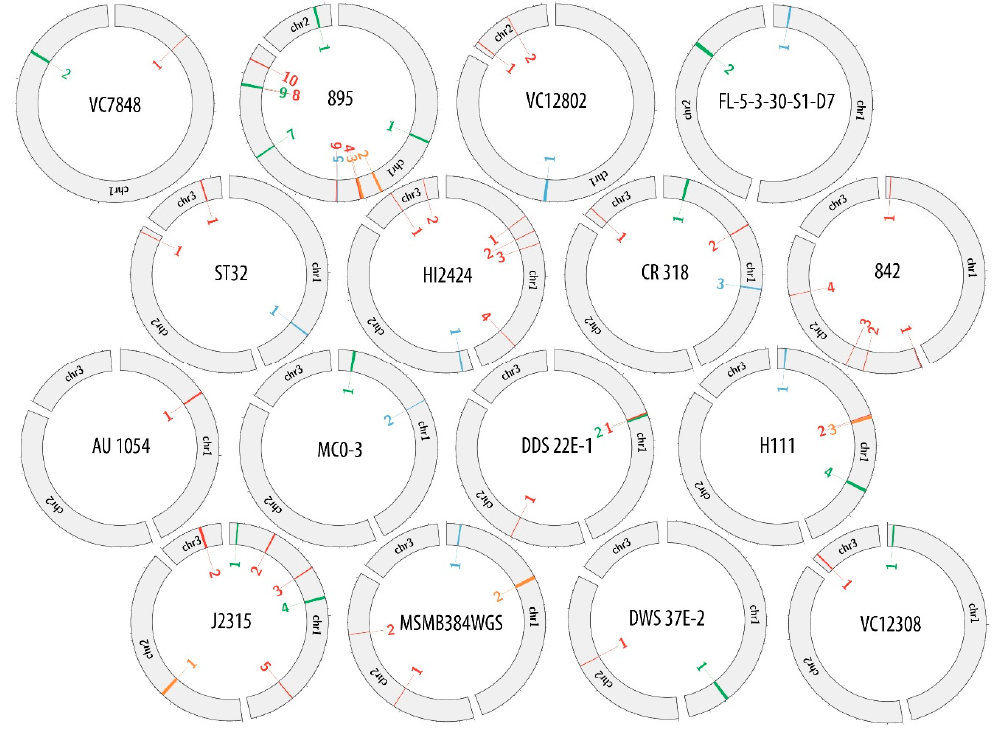
Figure 2. Genome maps of investigated B. cenocepacia strains depicting the location of found phage regions. Table 3. The prevalence of prophages within B. cenocepacia genomes.